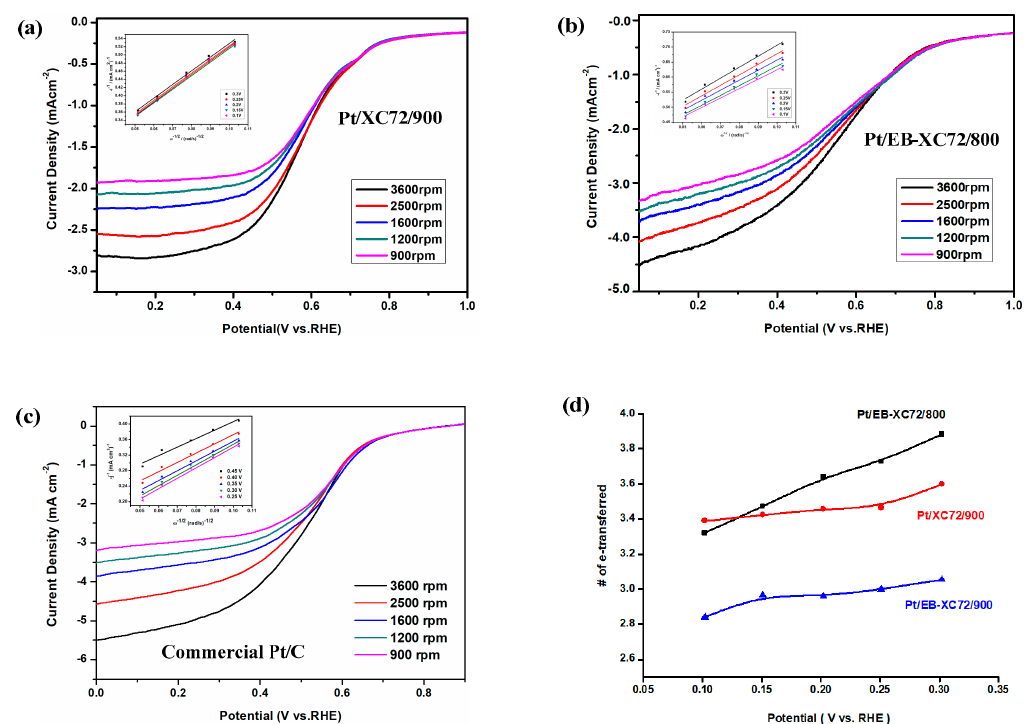
Figure 8. Linear sweep voltammetry (LSV) curves and Koutecky-Levich (K-L) plots of various Pt-electrodes. ( a ) Pt/XC72/900, ( b ) Pt/EB-XC72/800, ( c ) commercial Pt/C at different rotating rates, and ( d ) number of electrons transferred during ORR.